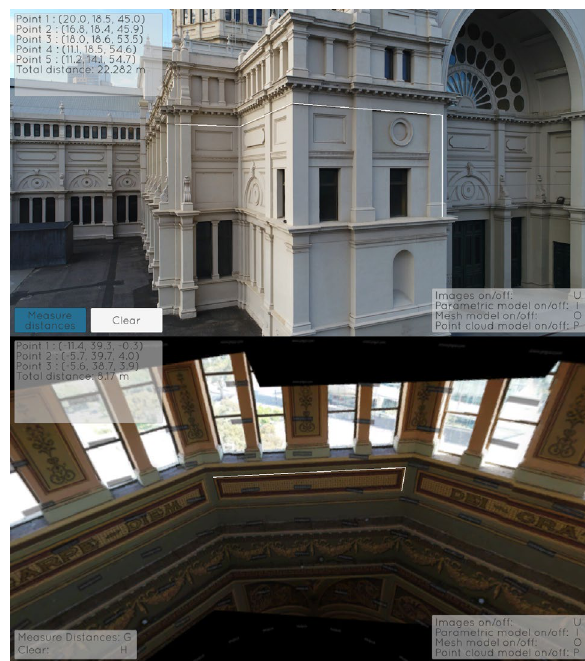
Figure 6. Distance measurements performed on images, 2D image on top and on a 360° panorama on the bottom.